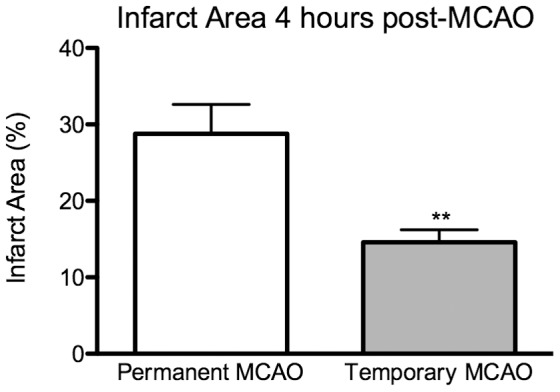
Infarct area at 4 hours.Infarct areas expressed as percentage of ischemic brain tissue identified on H&E staining on coronal section level with the optic chiasm; areas have been corrected for edema. **, p<0.01.